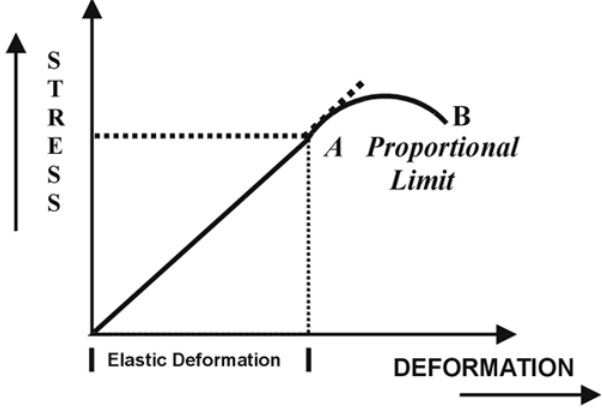
FIGURE 1- Stress-strain curve for hypothetical material: Proportional limit (A), elastic deformation (point A) and plastic deformation (between points A e B). Point B represents the moment of rupture of the material under tensile condition.